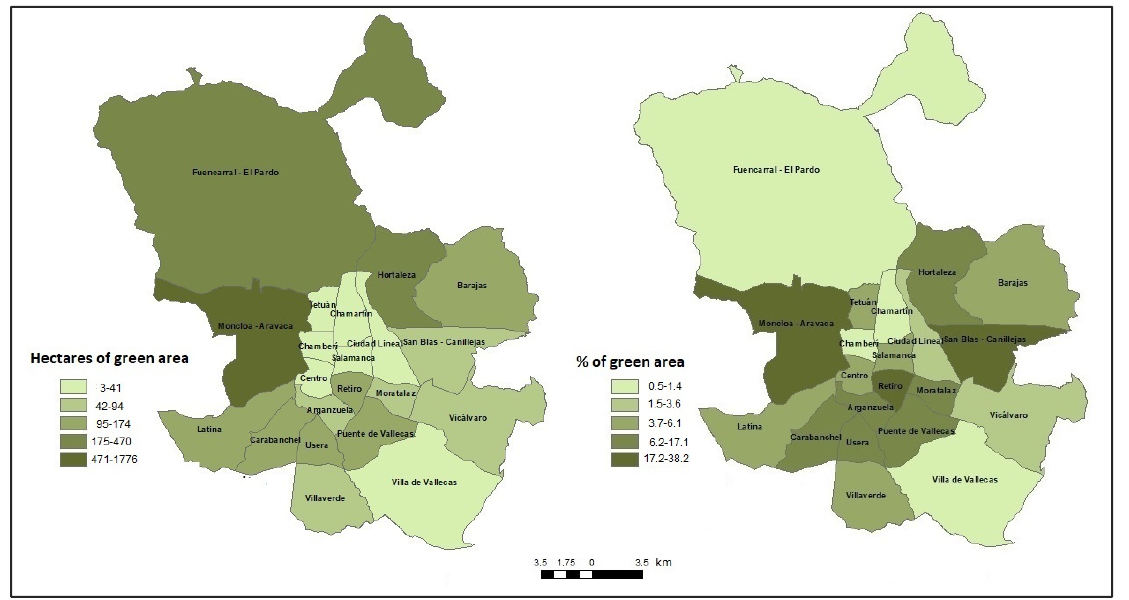
Figure 5. Absolute and relative green space in the districts of the municipality of Madrid. Source Ayuntamiento de Madrid [51].